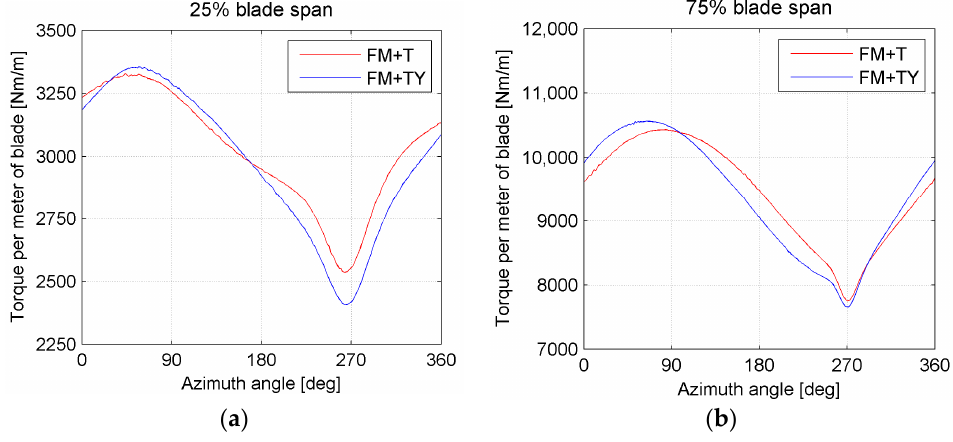
Figure 18. Torque (per meter of blade) contribution at two different spanwise locations: ( a ) 25% and ( b ) 75% of the total span. Comparison between the FM + T and FM + TY configurations.